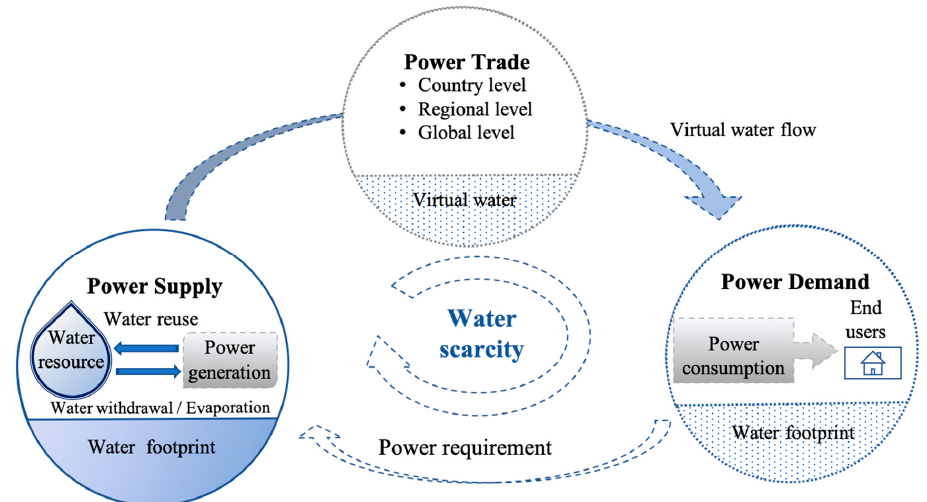
Figure 3. A cause-effect diagram tracking water use in power supply chains based on the water footprint and virtual water. footprint and virtual